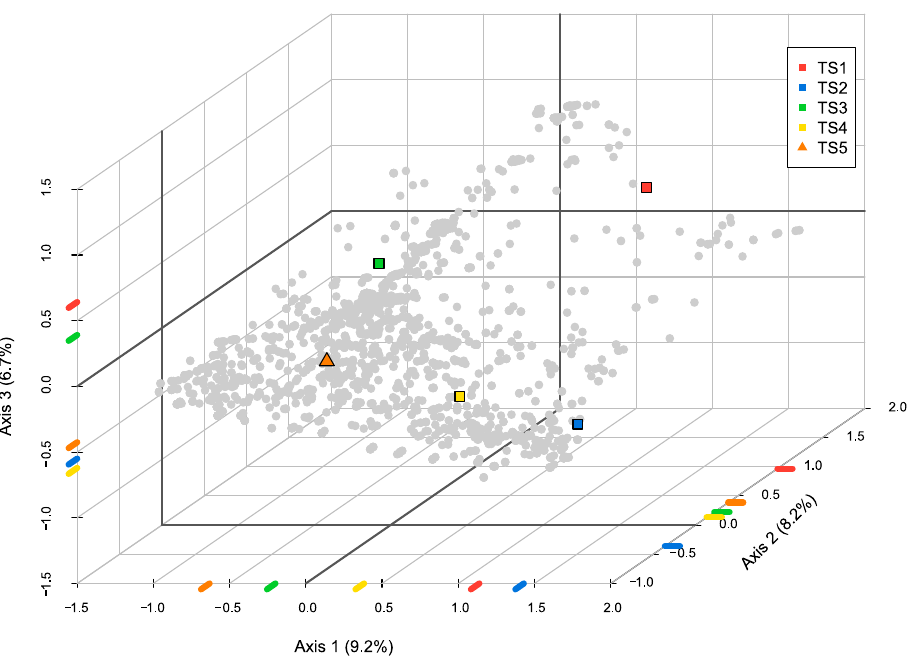
Figure 5. Results of the fuzzy correspondence analysis (FCA) applied to the diatom “species × trait” table. The average paragons best representing each trait syndrome have been projected—as supplementary individuals—on the space defined by the first three factorial axes (total explained variance in %). TS i corresponds to the trait syndrome i (with i = 1–5) identified by cluster analysis (Figure 2). Squares and triangles correspond to TS with mainly positive or negative correlations with micropollutants, respectively. Tags indicate the position of each paragon on the different axes.